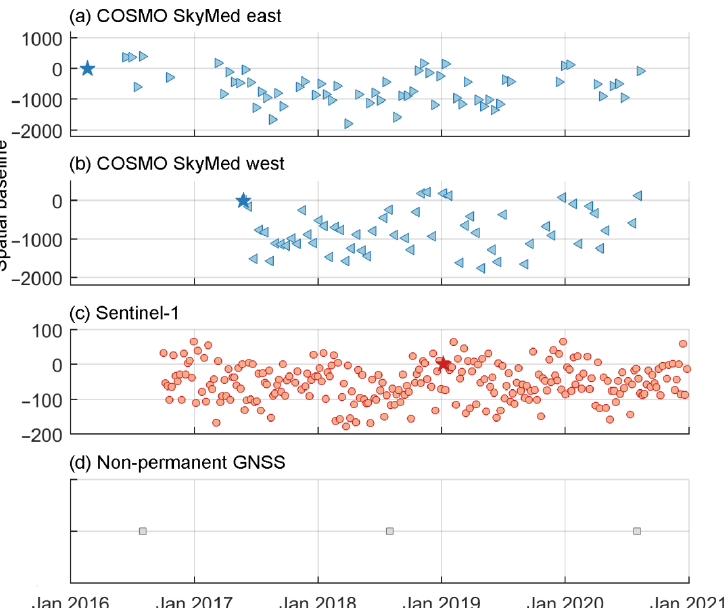
Figure 3. Spatial and temporal distribution of CSK in the east ( a ) and west ( b ) stacks, and Sentinel-1 ( c ): the pentagrams representing the primary images and other symbols indicating the secondary images. ( d ) Temporal distribution of non-permanent GNSS. CGNSS data of TGPO, PTO1, and CODI stations were available continuously in the analyzed period. Multi-temporal InSAR (MT-InSAR) techniques have become a widely used tool for monitoring land surface deformation. The two main classes of MT-InSAR techniques are